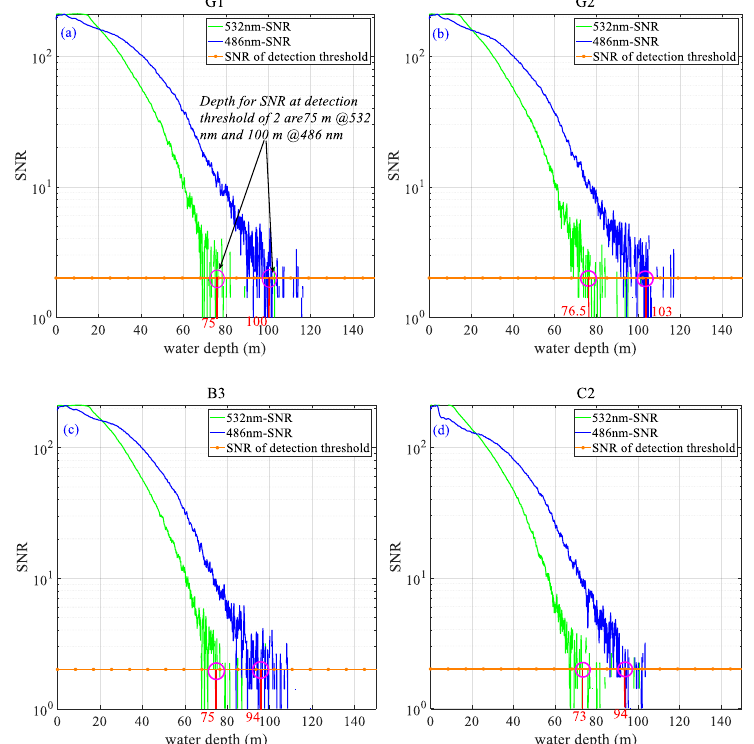
Figure 16. Signal-to-noise ratio (SNR) of the receiving signal photons. ( a ) SNR of G1 ; ( b ) SNR of G2 ; ( c ) SNR of B3 ; ( d ) SNR of C2 . The SNR threshold of detection for our DWOL system is 2. The corresponding depth indicated by the red lines were obtained based on the median values of depth when the SNR was lower than 2.